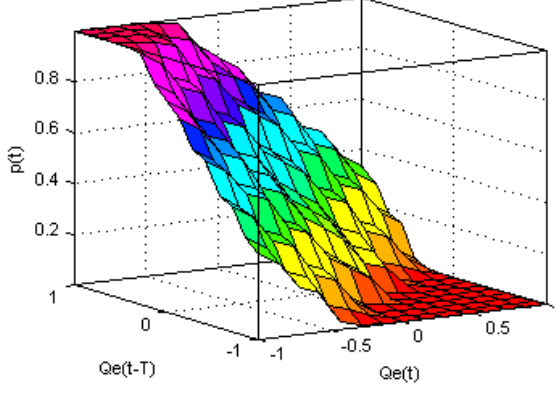
Figure 7. The deductive surface of the FLRED